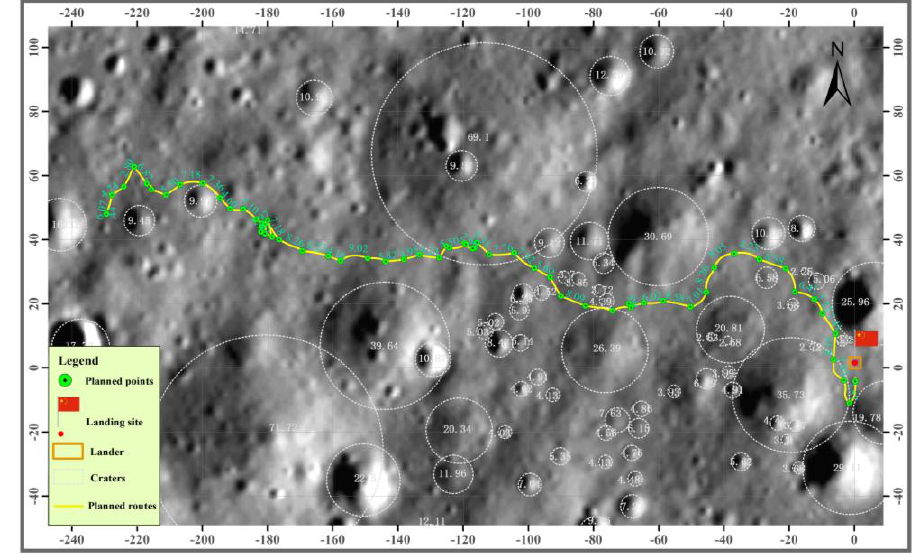
Figure 12. Yutu-2 traverse map of the first 12 lunar